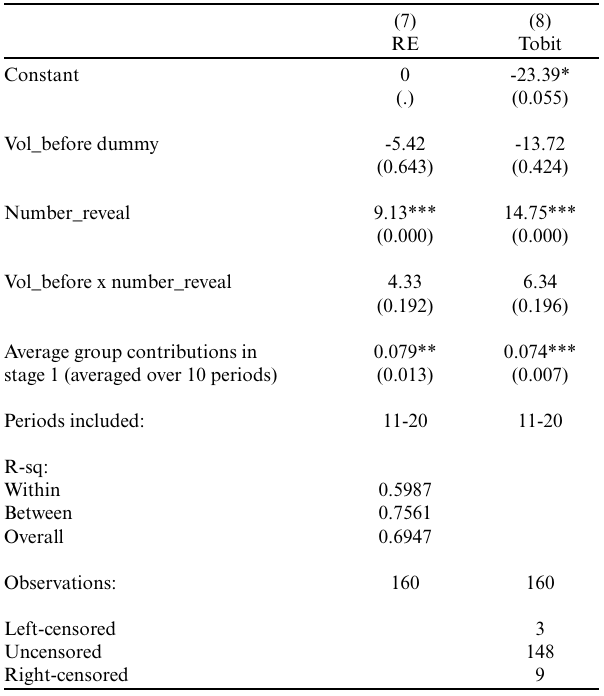
Table 5 . Regression analysis of group-level contributions in voluntary treatments.